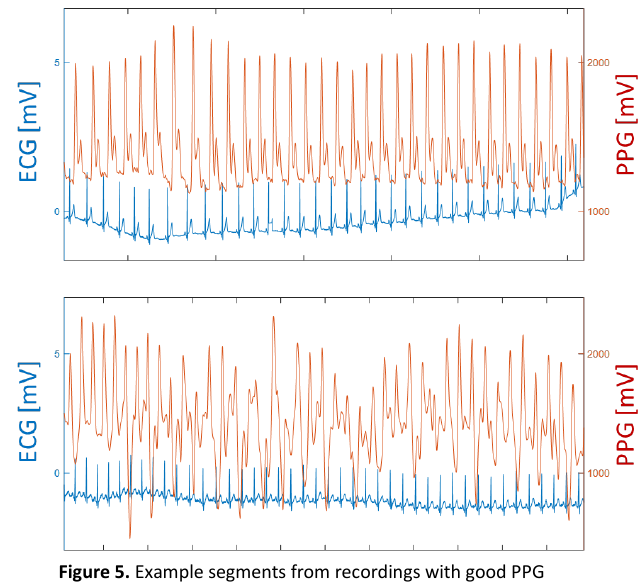
Figure 5. Example segments from recordings with good PPG signal quality (a), during the resting phase, and with poor PPG signal quality (b) during the exercise phase.